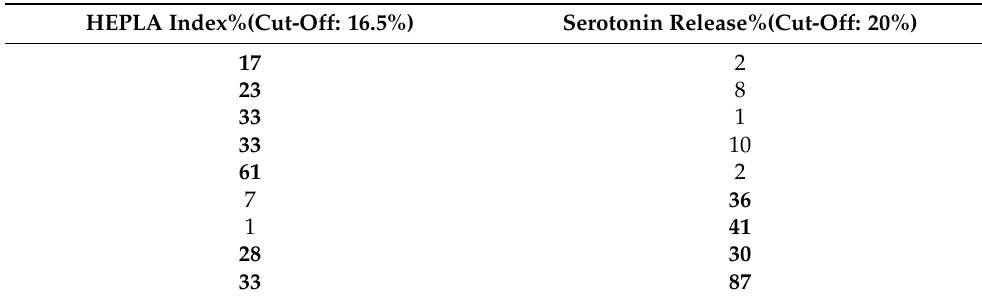
Table 7. Values of the HEPLA index (%) and serotonin release (%) for false positive results of FCA and/or SRA. The values of the false positive results are in